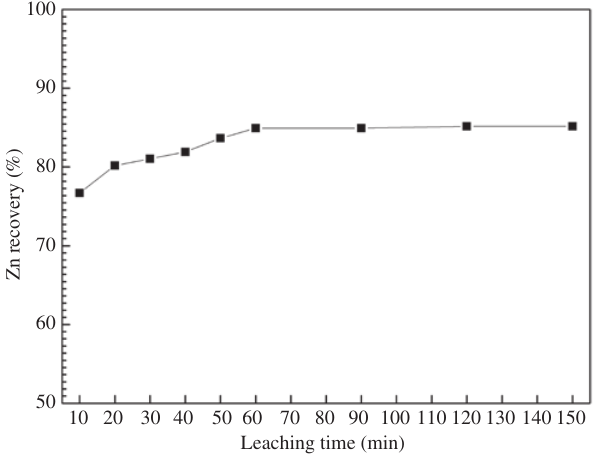
Figure 9: Effects of leaching time on zinc recoveries of the roasted